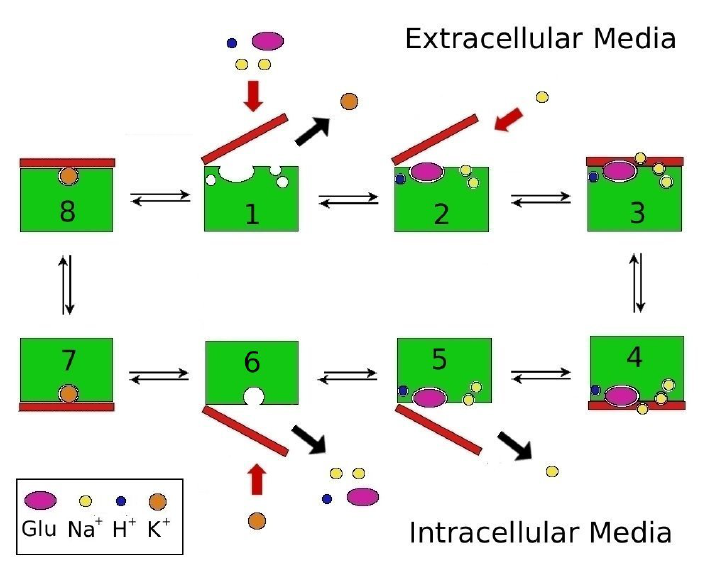
Figure 1. Mechanism of coupled-glutamate transport in EAATs. Step 2 shows the binding of the Na2 ion, which occurs after the binding of the substrate and the closure of the HP2 gate. Step 5 shows the opposite happening in the inward-facing state. Steps 3 and 4 correspond to the translocation of the transport domain across the membrane with 3 Na + , H + , and Glu bound to EAAT, while steps 7 and 8 depicts the same with only K +